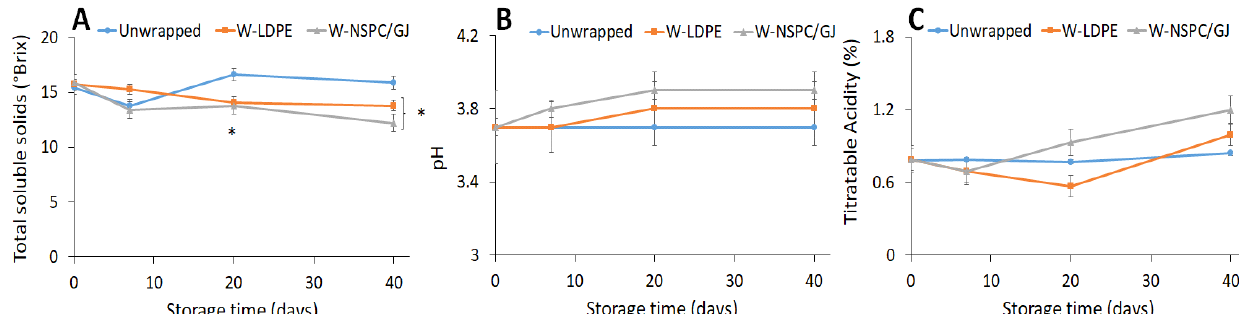
Figure 5. Sweet cherries image after removing from freezer: unwrapped (control) and wrapped (W) with LDPE or NS PC with 6% GJ.